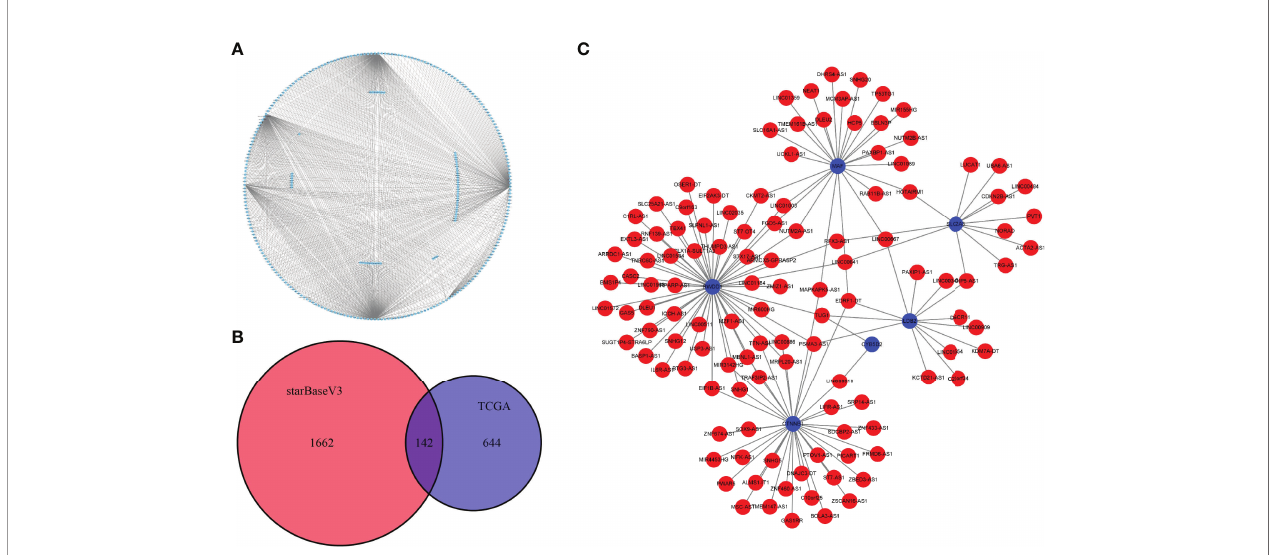
FIGURE 8 | Construction of the mRNA – lncRNA interaction network. (A) The ceRNA global network of mRNA – lncRNA pairs with correlation coef fi cients >0.4 and p < 0.05 was analyzed by the Hmisc package. (B) The Venn diagram shows the intersection of the mRNA – lncRNA pairs obtained from the starBase V3.036 database and the mRNA – lncRNA pairs calculated by the Hmisc package. (C) The interaction network of 142 mRNA – lncRNA pairs; blue for mRNA and red for